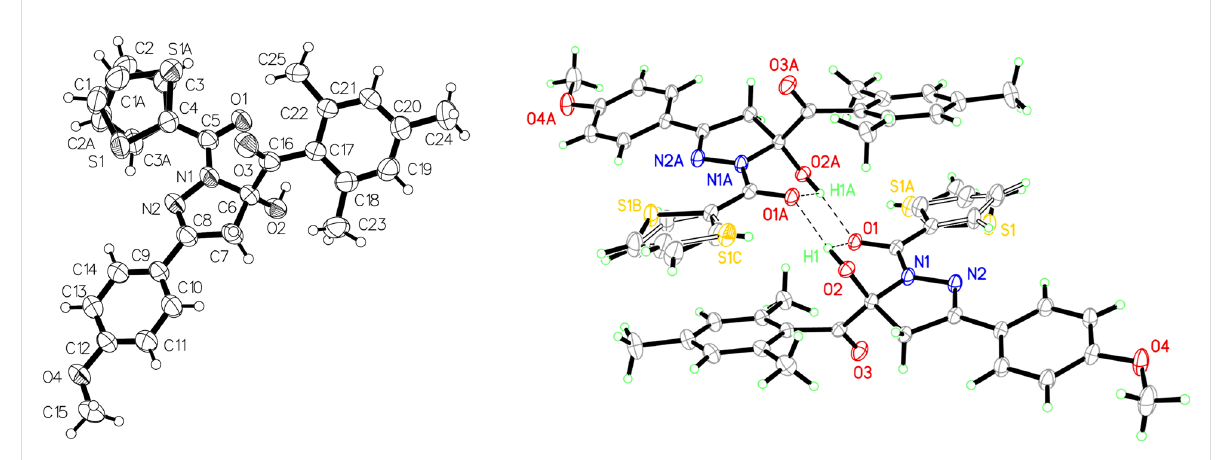
Figure 5: ORTEP plot and dimer of compound 5r (thermal ellipsoids at 30% probability).